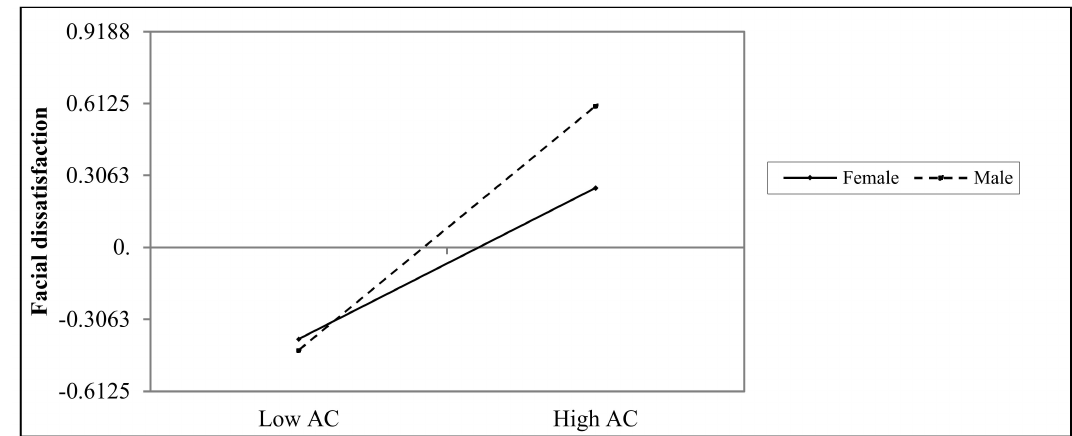
Figure 3. The interaction between appearance comparisons and gender on facial dissatisfaction. AC = appearance